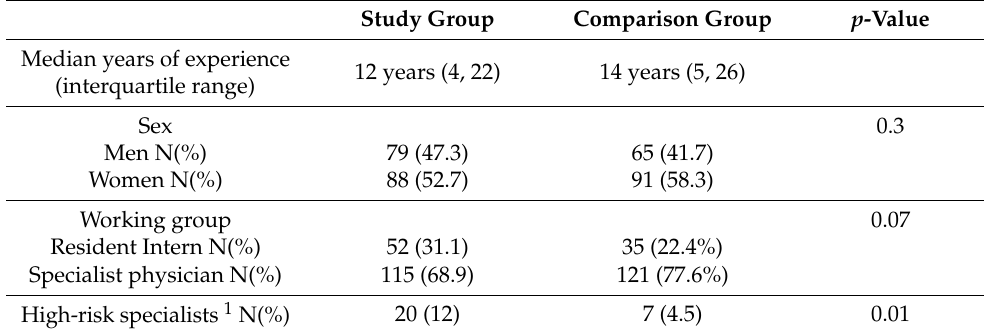
Table 1. Group description.